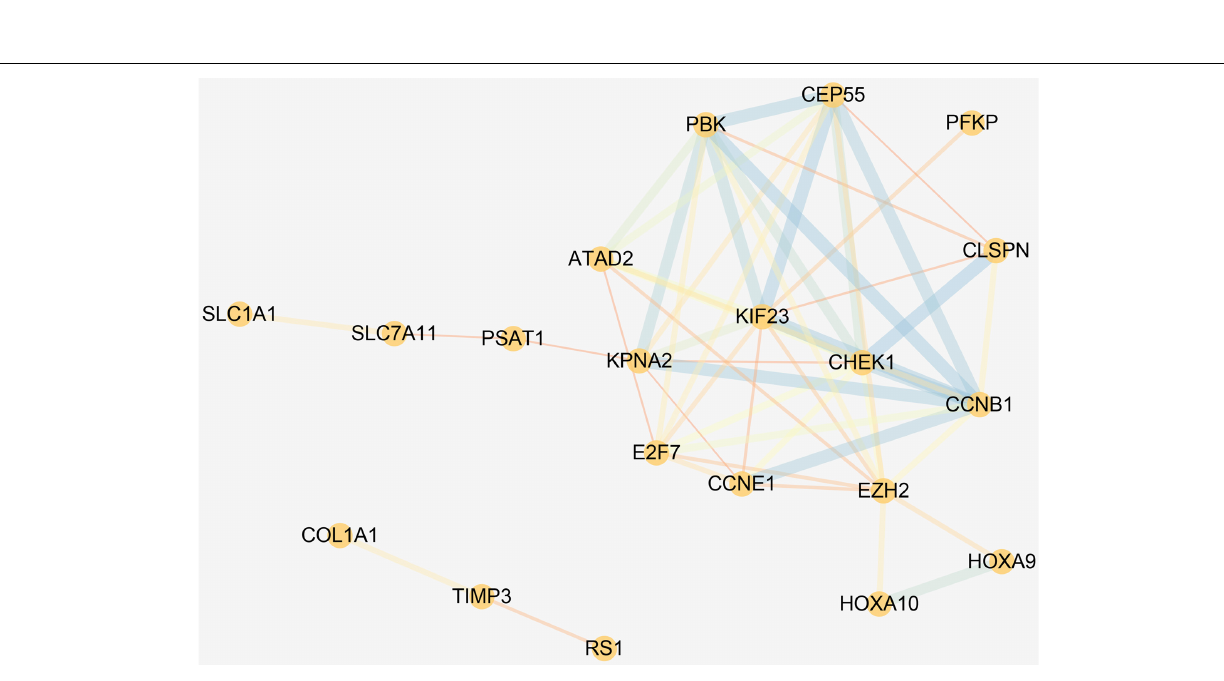
Frontiers in Oncology |